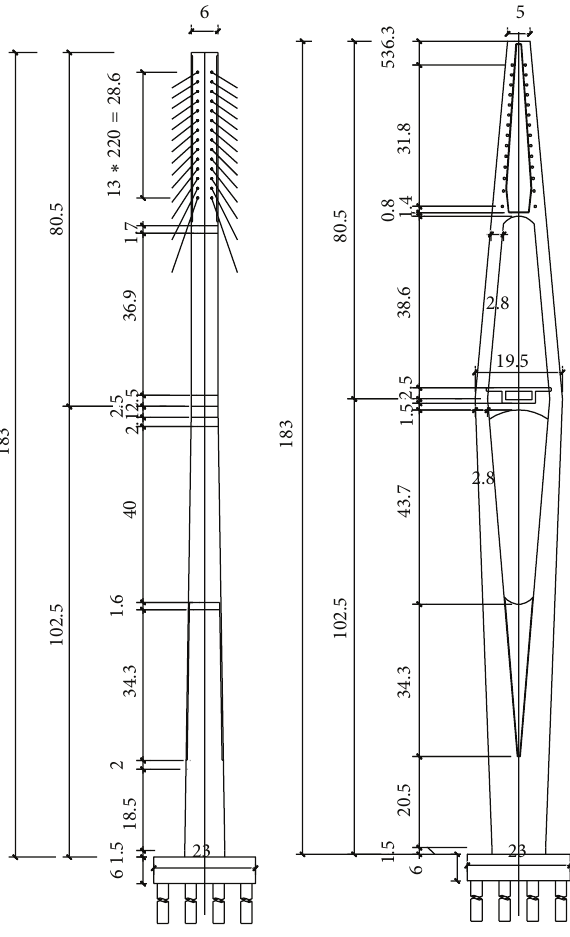
Figure 2: Pylon of the bridge (unit: